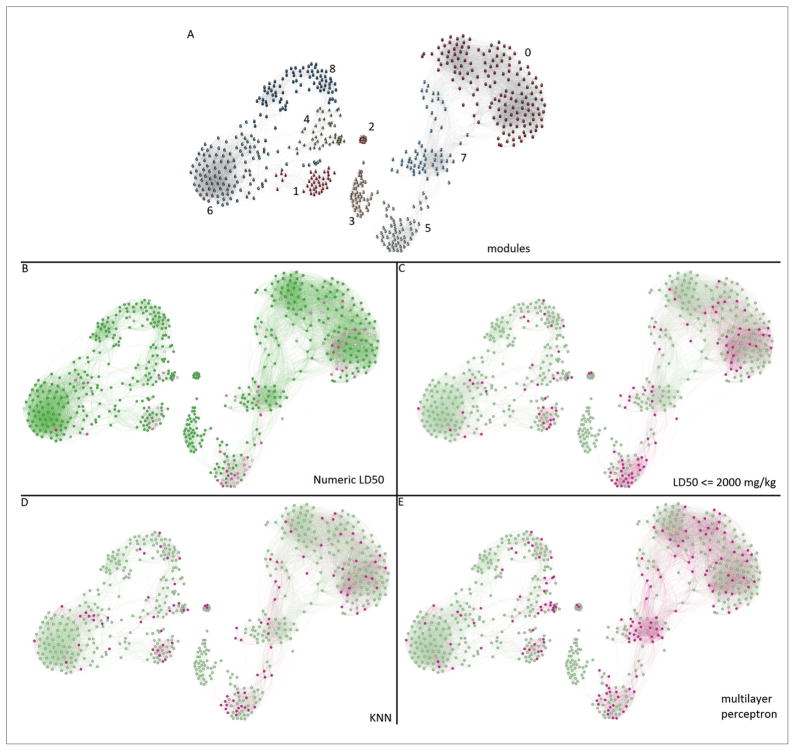
Chemical similarity maps for substances with acute oral toxicity LD50 data that could be mapped from REACH to PubChemThe map contains 613 substances and is built from 3,122 substances mapped from REACH to PubChem and for which similarity and structure data could be determined from the chemistry development kit (Bolton et al., 2008; Steinbeck et al., 2003). Edges are shown between substances with similarity ≥ 0.7 as determined by their Tanimoto distance (Lourenço et al., 2004). The force layout algorithm is used to distribute substances (Fruchterman and Reingold, 1991).A. Similarity map modules: Nine modules are created by maximization of the Q-metric, a measure of module coherence (Blondel et al., 2008). Chemical nodes are colored by their module identification.B. Chemical similarity map colored by experimental LD50: Dark pink = low LD50, white = 1,000 mg/kg b.w./day, dark green = 2,000 mg/kg b.w./day. Results based on average LD50 values. Clusters of low LD50 values can be seen in module 5 and 0 with some otherwise sporadic distribution.C. Chemical similarity map colored by oral toxicant status: Pink substances denote LD50 < 2,000 mg/kg b.w. per day. Green substances denote LD50 ≥ 2,000 mg/kg b.w. per day (not classified).D. KNN classifications for LD50: Pink = predicted LD50 < 2,000 mg/kg b.w. per day. Green = predicted LD50 ≥ 2,000 mg/kg b.w. per day.Substances are predicted as toxicant if the majority of the closest 5 neighbors are toxicants. A chemical is considered a neighbor if it has Tanimoto similarity > 70% (Lourenço et al., 2004).E. Multilayer perceptron classifications for LD50: Pink = predicted LD50 < 2,000 mg/kg b.w. per day. Green = predicted LD50 ≥ 2,000 mg/kg b.w. per day. Classifier built on 1,059 substances referenced by at least one acute oral study with Klimisch score = 1. Classifications made by the multilayer perceptron appear to be well clustered; this indicates that chemical descriptors are influenced by substructure presence.